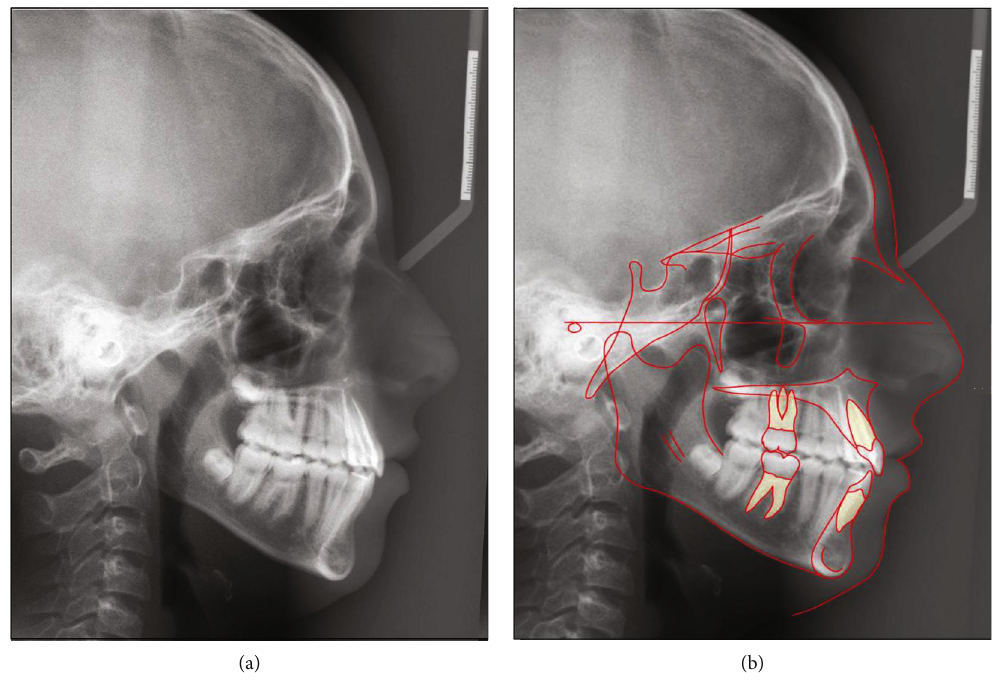
Figure 13: (a)Cephalometric radiograph and (b) cephalometric tracing after